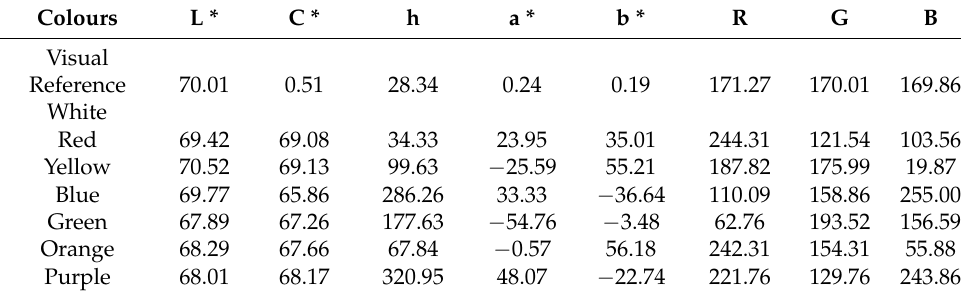
Table A1. The Characteristics of the Background Colours.